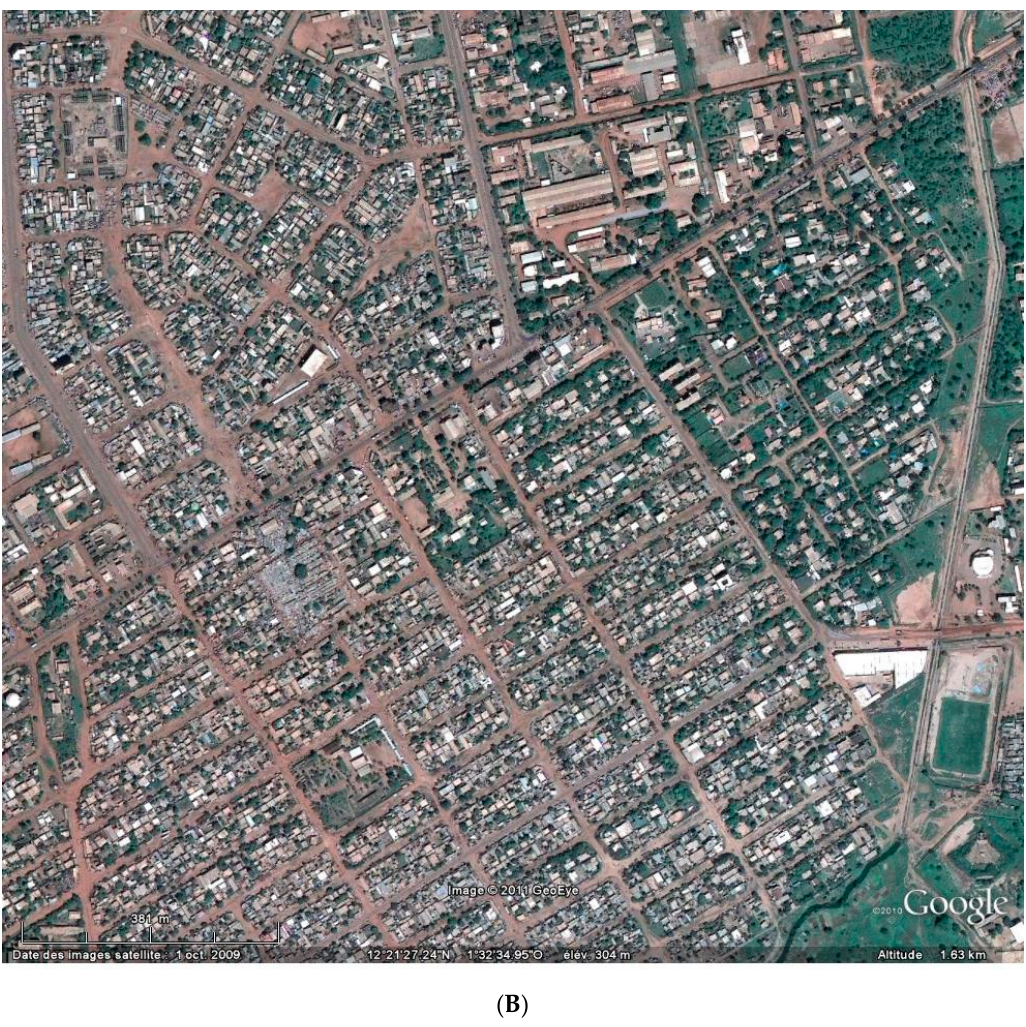
Figure 3. Aerial view of two districts of the study area in 2010 (Google Earth ® ). ( A ) Tanghin with a lot of land reserves; and ( B ) Gounghin with a high building density and no land reserve.